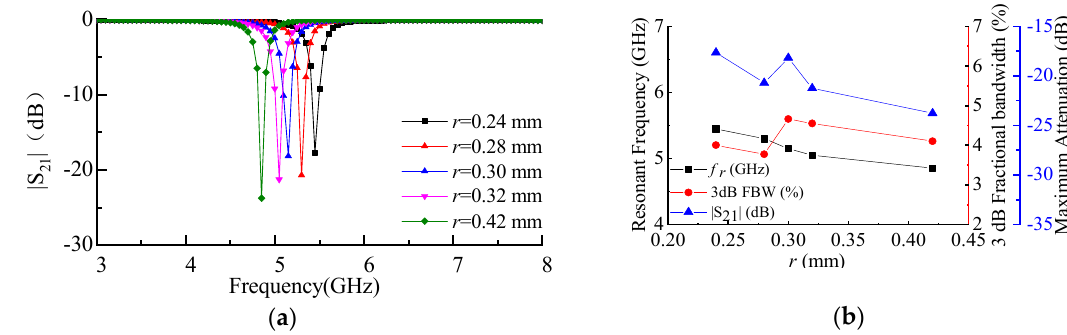
Figure 5. ( a ) Simulation results with different r by using HFSS. ( b ) Resonant frequency, maximum attenuation, and 3 dB Fractional Bandwidth with different r.